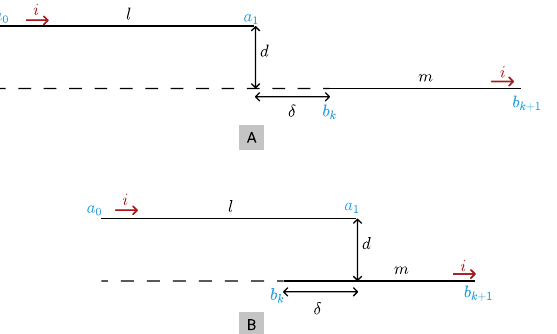
Figure 3. Mutual Inductance’s general case of two parallel filaments, ( A ): two filaments non over- lapped; ( B ): two filaments overlapped.